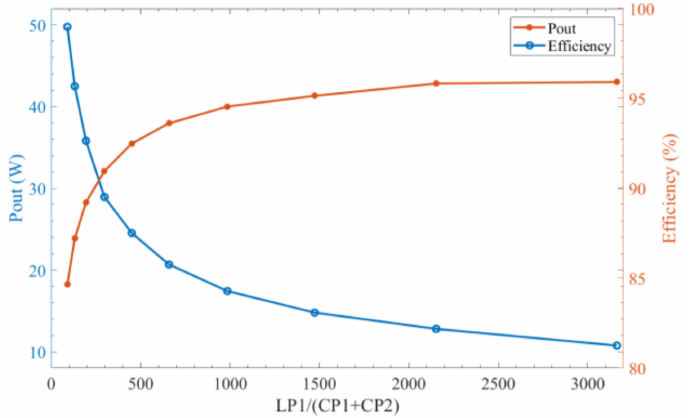
Figure 11. The efficiency and P out of 10 kHz DP2P mode with different value of LP 1/ ( CP 1 + CP 2 )